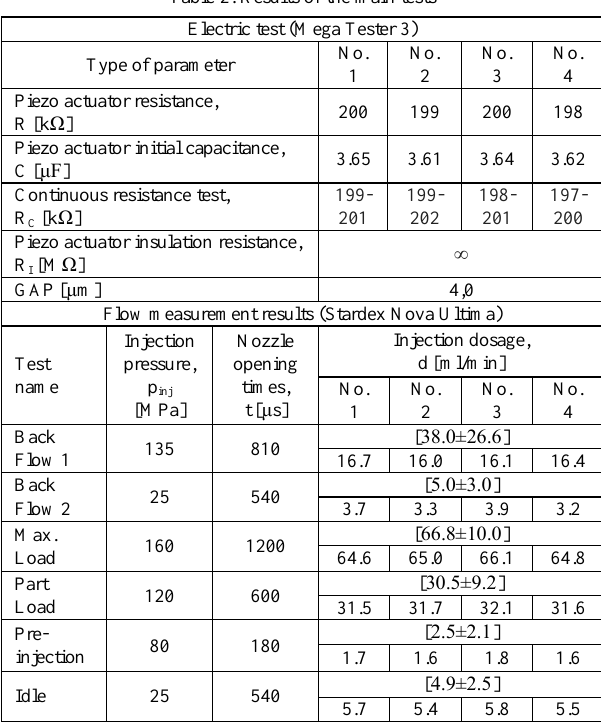
Fig. 10. Measurement of the thickness of the actuator shim Table 2. Results of the main